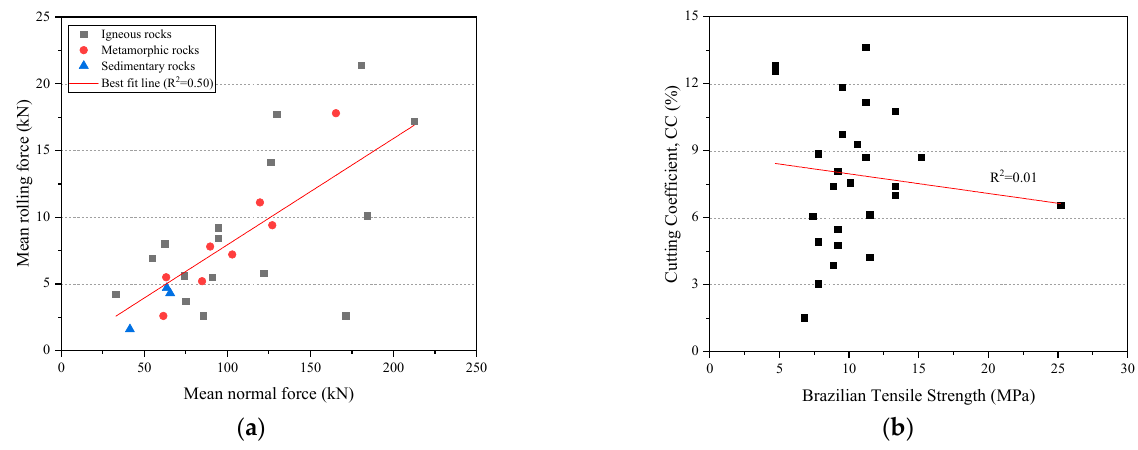
Figure 6. Cutting coefficient for full-scale linear cutting tests: ( a ) range of CC; ( b ) CC vs. BTS.